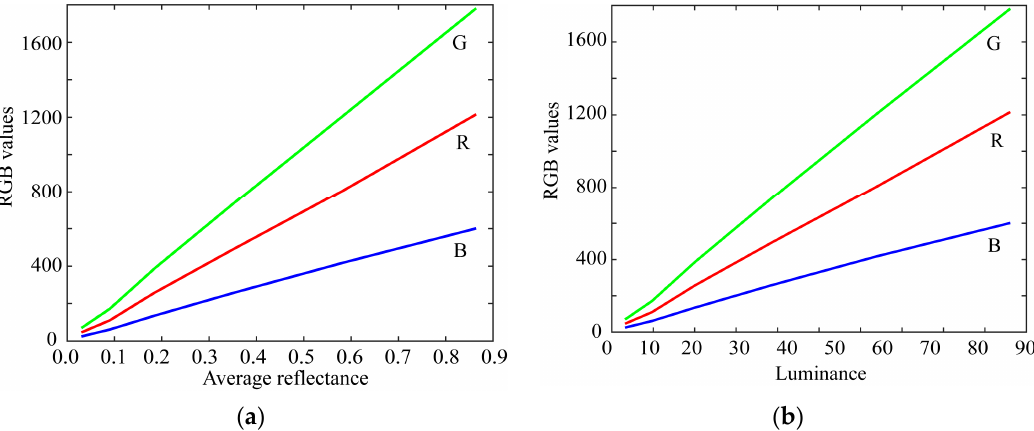
Figure 1. Linearity test of the raw camera data using color samples. ( a ) Relationship between the average reflectance of gray chips and the camera RGB outputs. ( b ) Relationship between the luminance values and the camera RGB outputs.